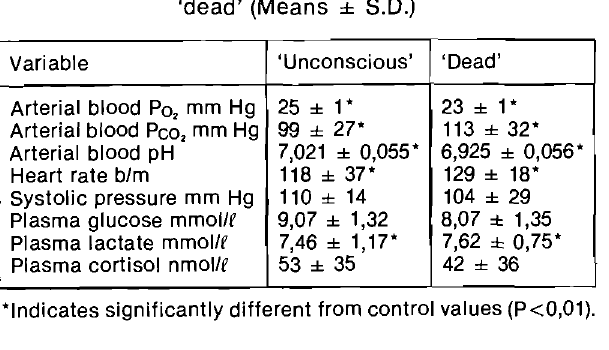
Table 4: Values of variables for Group 3 (low oxygen, high carbon dioxide) animals when 'unconscious' and 'dead' (Means ±